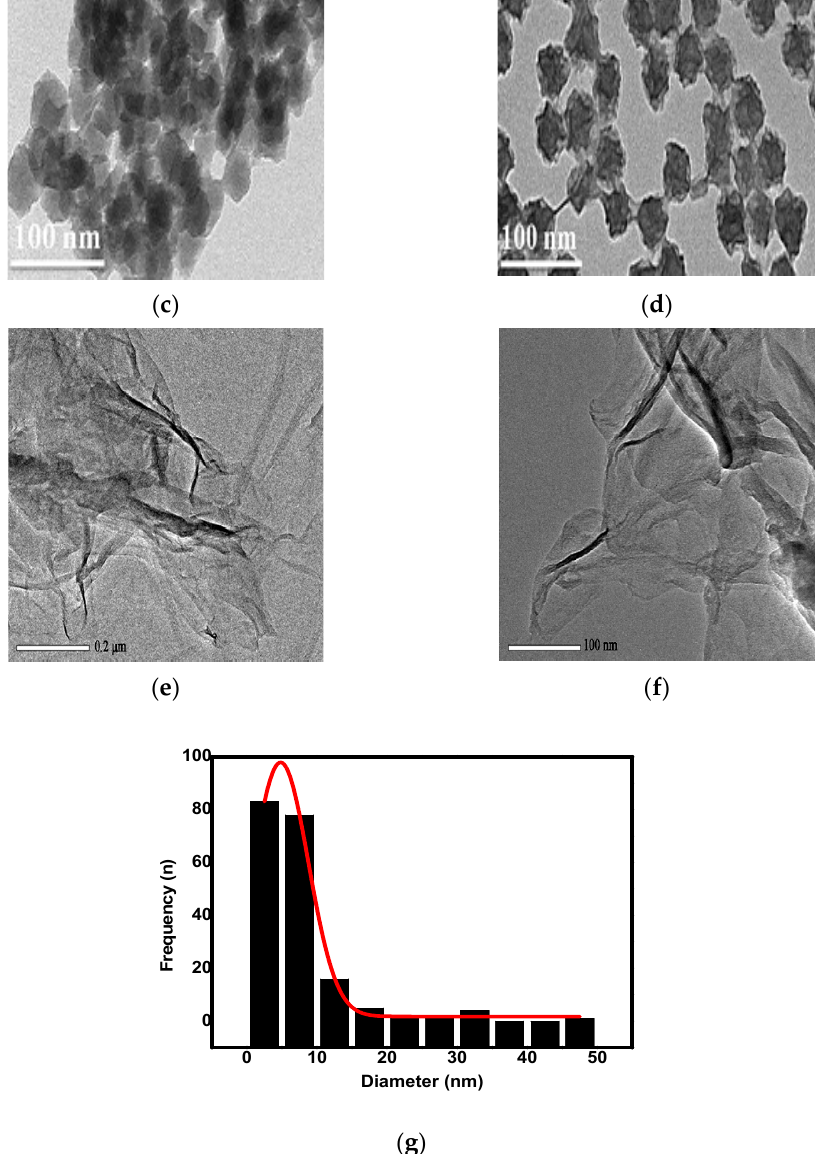
Figure 1. TEM image of ( a ) HPAN-PRGO; ( b ) PAN-PRGO; ( c ) HPAN; ( d ) PAN; ( e ) GO; ( f ) GO-NH 2 ; and ( g ) the particle size distribution of HPAN-PRGO nanocomposite.